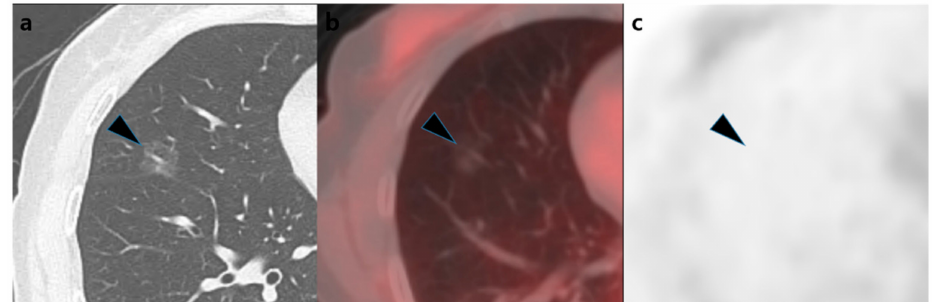
Figure 3. An example of adenocarcinoma in situ. A 60-year-old woman’s chest computed tomography showing a 17 mm ground-glass nodule (black arrow head) ( a ) with visually negative [ 18 F]FDG uptake ( b , c ). The Hounsfield units value of the nodule was − 644, and the SUV max increased from 0.52 to 1.53 after tissue fraction correction, which was lower than the cutoff value of 2.50. The nodule was diagnosed as adenocarcinoma in situ after